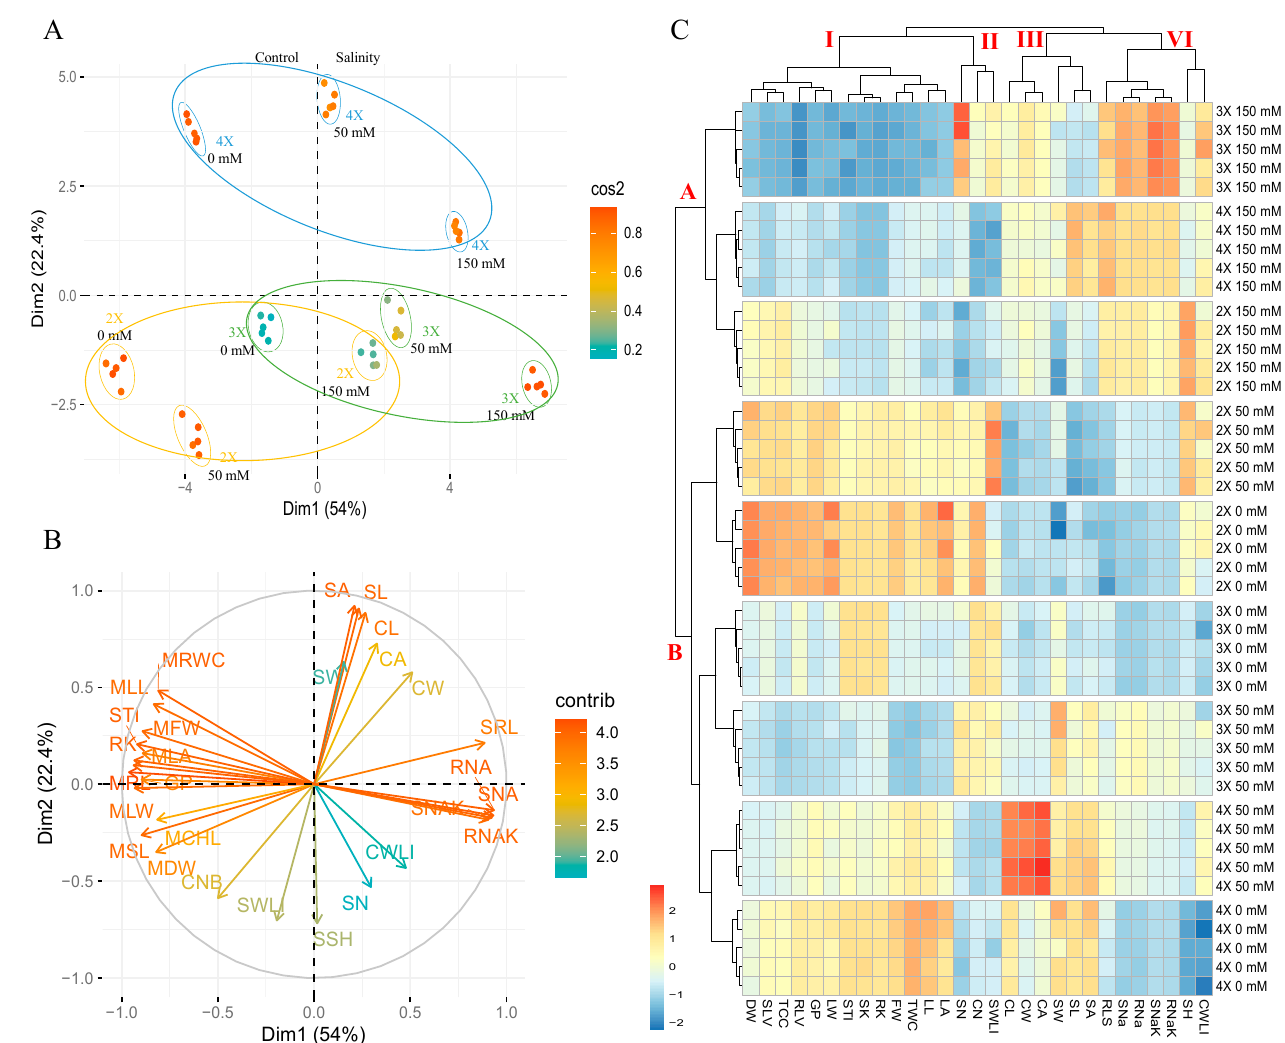
Figure 5. The evaluation of all traits and genotypes by principal component analysis (PCA) and hierarchical clustering analysis (HCA). ( A ) Principal component analysis (PCA) of diploid (2X), triploid, (3X), and tetraploid (4X) sugar beet ( Beta vulgaris L.) genotypes subjected to 0 (control), 50, and 150 mM of NaCl (salt stress) treatments; ( B ) bi-plot analysis to check the effects of traits on the individuals; ( C ) hierarchical clustering analysis (HCA) visualized with a heatmap of 3 sugar beet genotypes under control and stress conditions. GP: Germination percentage, STI: salt tolerance index, SH: Seedling height, RLS: root content, CN: cell number, CL: cell length, CW: cell width, CA: cell area, CWLI: cell width/length index, length (Seedling), SHV: shoot height (Vegetative), RLV: root length (Vegetative), LL: leaf length, LW: leaf width, LA: leaf area, FW: fresh weight, DM: dry matter, TWC: tissue water content, TCC: total chlorophyll, SN: stoma number, SL: stoma length, SW: stoma width, SA: stoma area, SWLI: stoma width/length index, SNa: shoot Na + concentration, SK: shoot K + concentration, SnaK: Shoot Na + /K + ratio, Rna: root Na + concentration, RK: root K + concentration, and RNaK: root Na + /K + ratio, clusters (I–VI and A–B). Means (±standard deviation) within the same graph followed by letters are significantly different at p < 0.05 according to Tukey HSD test from three to five independent biological replicates ( n = 5).